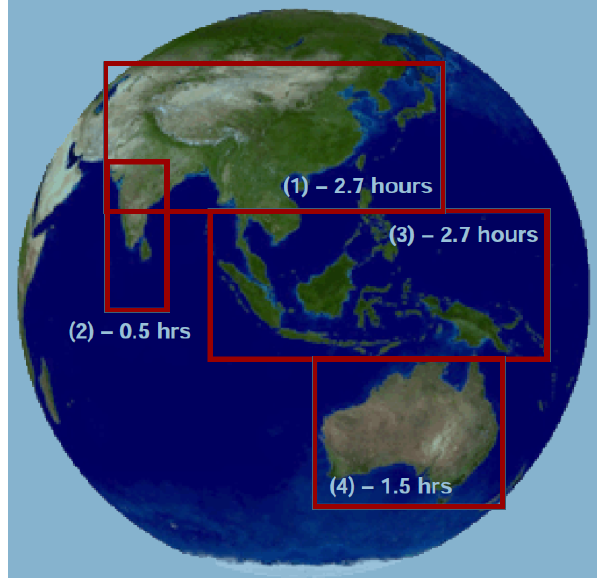
Fig. 1. At 110 ◦ E geoCARB scans India, China, Indonesia, Japan and Australia with four scan blocks in less than 8 hours.